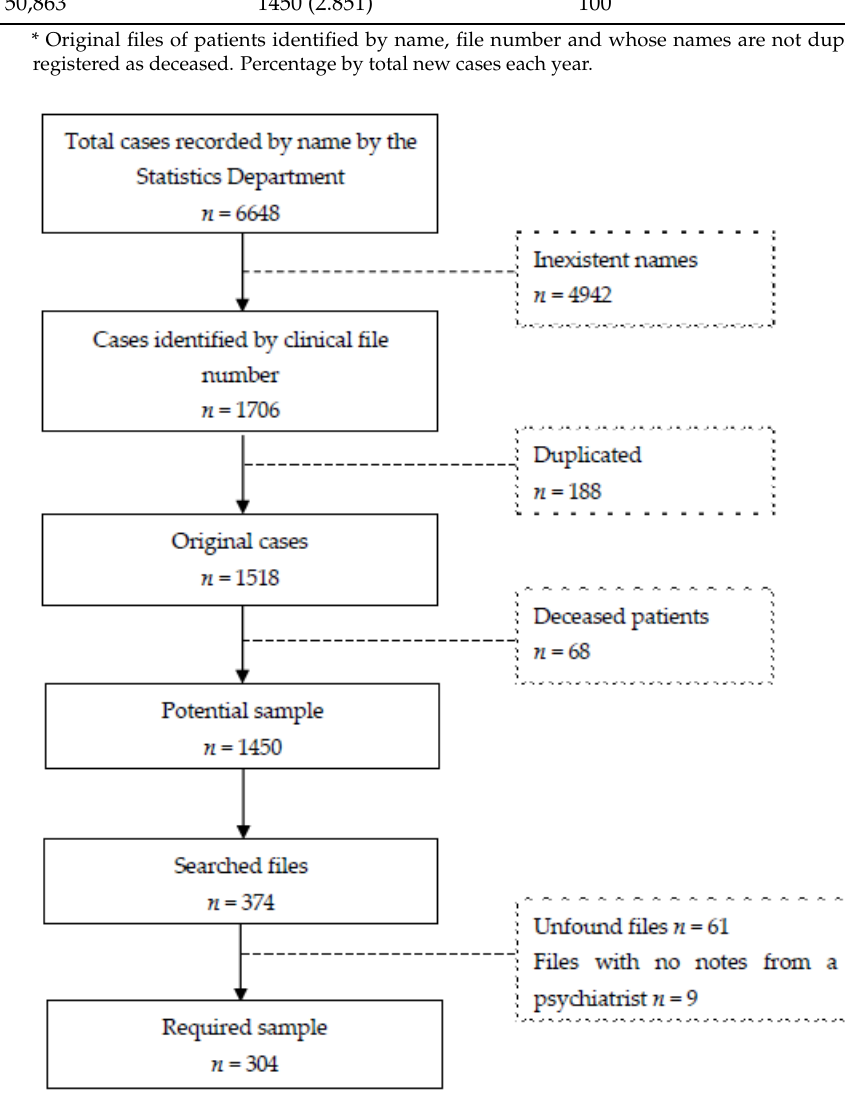
Figure 1. Sample flow